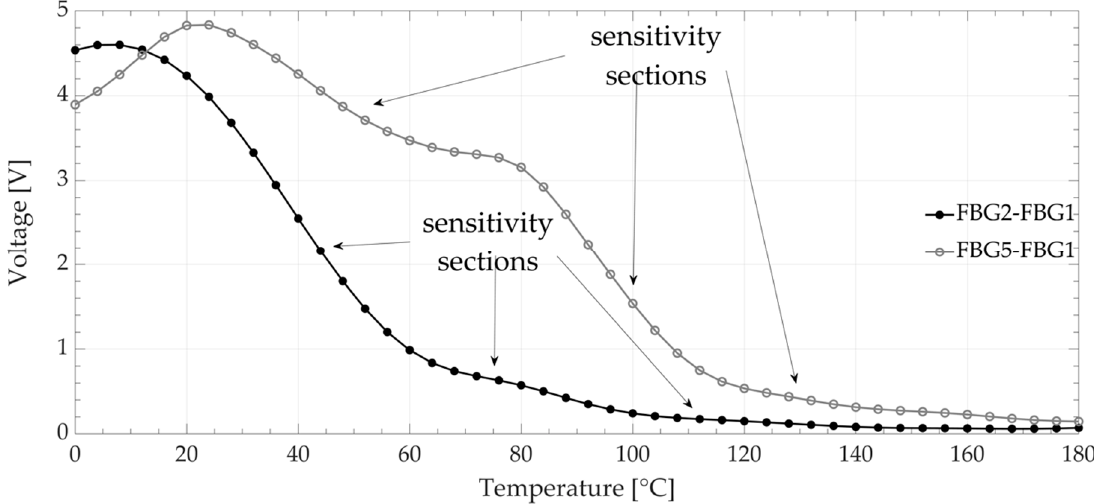
Figure 8. Experimental transfer characteristics.